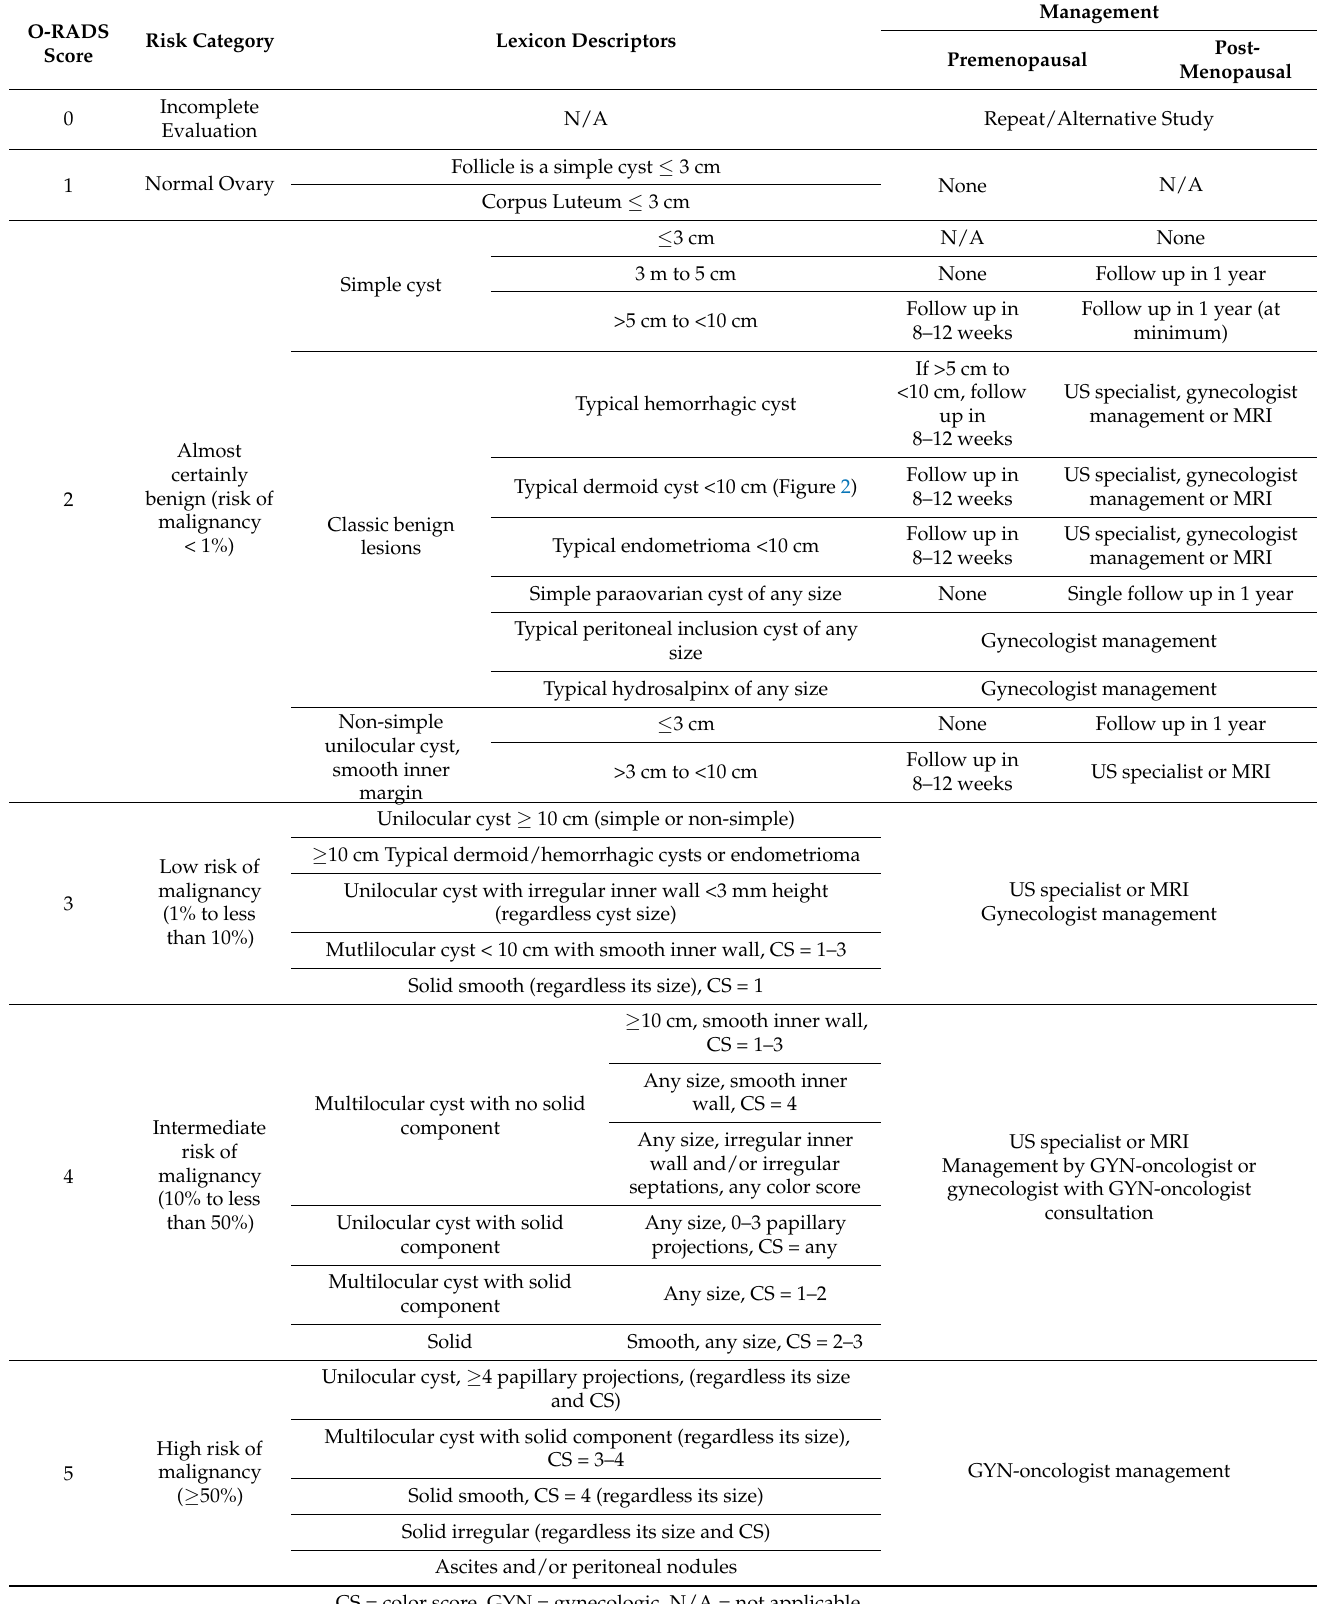
Table 1. Ovarian-Adnexal Reporting and Data System (O-RADS) US risk stratification and manage- ment